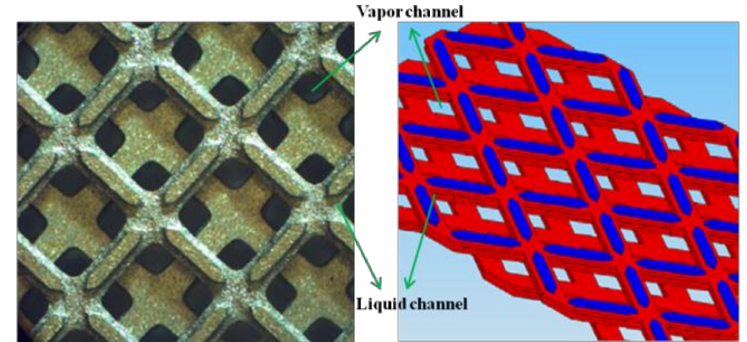
Figure 1. Schematic diagram of dual-mode microwick